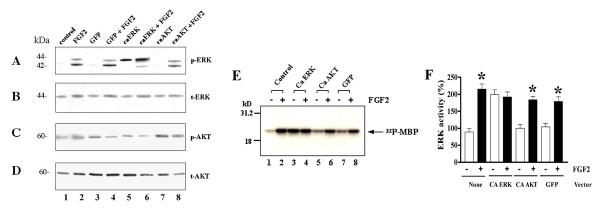
Effects of gene transfer of constitutively active ERK, AKT or GFP phosphorylation (A-D) Western Blot of HUVEC after treatment with FGF2, infected with the GFP, ca ERK or ca AKT adenoviral constructs, or treated with FGF2 and infected with adenoviral constructs. The same Western blot was used for all antibodies after stripping and rehybridizing. A) Reacted with anti-phospho ERK antibody (B) reacted with anti-total ERK antibody. (C) Reacted with anti-phospho AKT antibody. (D) Reacted with anti-total AKT antibody. (E) Immuno-complex assay showing changes in ERK activity with or without FGF2 treatment in HUVEC with caERK, caAKT or GFP. (F) Quantification of ERK activity levels in HUVEC +/- FGF2 treatment with caERK, caAKT or GFP with the PhosphorImager as described in the Materials and Methods. * indicates a significant difference from control. * = P < 0.05 by One-Way ANOVA with post-hoc Dunnett's when compared to control.